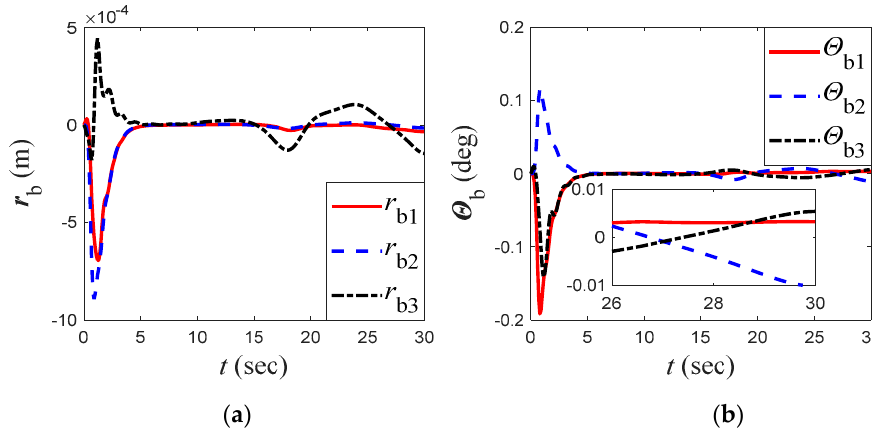
Figure 11. ( a ) Position of the platform; ( b ) attitude of the platform.